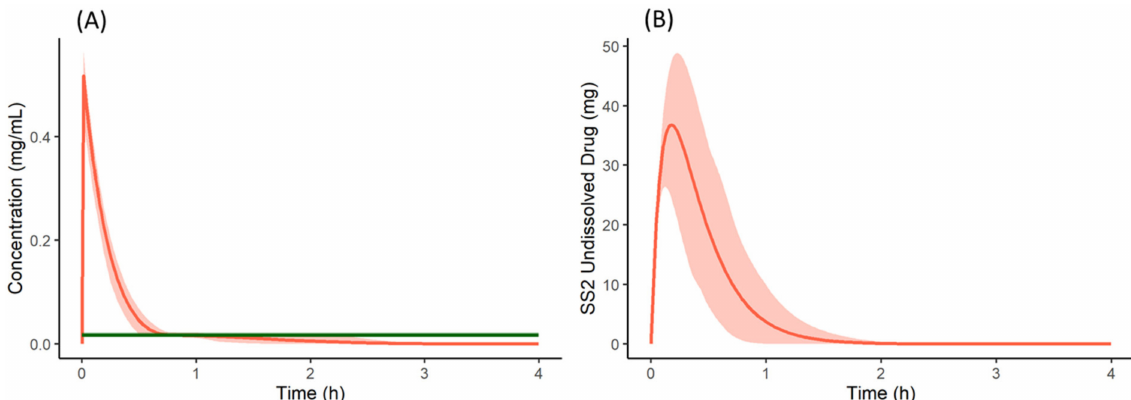
Figure 11. ( A ) Total concentration (Red) and bulk fluid equilibrium solubility (green) of the drug in stomach when co-dosed as a salt form with famotidine. ( B ) Undissolved (precipitated) drug of Solid State 2 (free form) in the stomach when the salt form of the drug is co-dosed with famotidine. Solid lines represent mean and shaded area represent 5th and 95th percentiles of 100 simulated individual profiles.